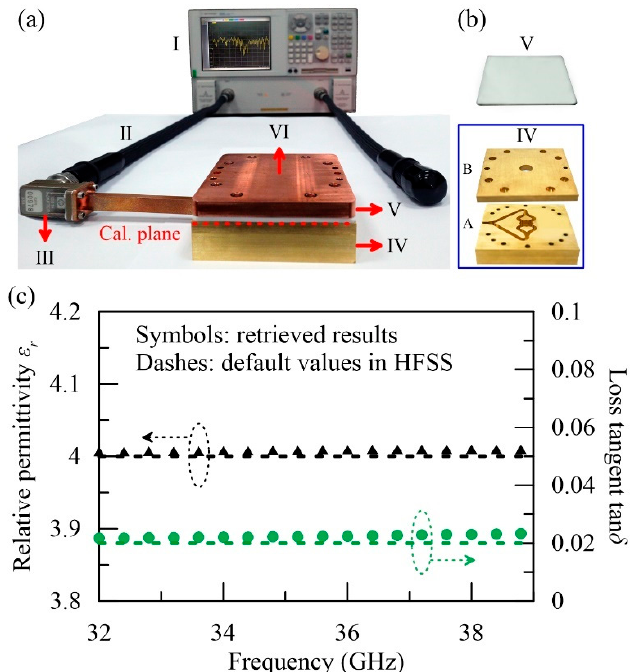
Figure 3. ( a ) Experimental setup. Part I: performance network analyzer. Part II: 2.4 mm flexible coaxial cable. Part III: rectangular TE 10 mode converter. Part IV: home-made circular TE 01 mode converter, composed of a power-dividing junction (component A in ( b )) and a mode-converting tube (component B in ( b )). Part V: sample under test. Part VI: back metal plate. ( c ) Retrieved results obtained by HFSS simulation. Black triangles (green circles): retrieved ε r (tan δ ) based on the theory proposed in Section 3. The corresponding default values set in HFSS are plotted in dashed curves for comparison.